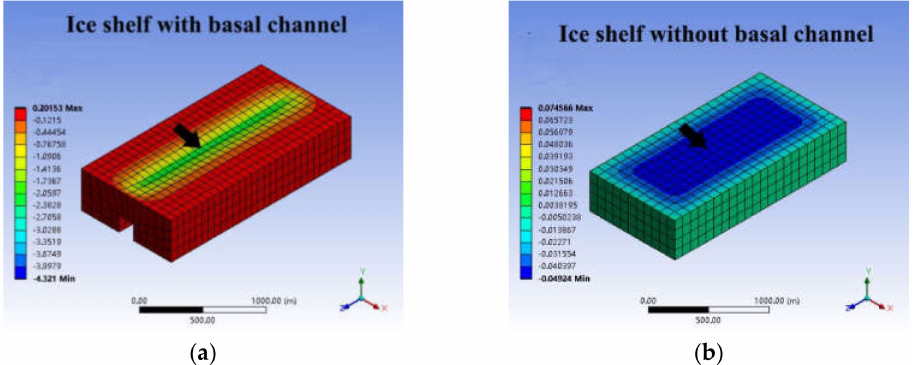
Figure 3. The annual deformation of the ice shelf under the action of its own gravity and buoyancy e ff ect of seawater. ( a ) The ice shelf with a basal channel, the corresponding position of surface appears obvious depression. ( b ) The ice shelf with no basal channel, there is no obvious depression on the ice shelf surface (1 year = 3.139 × 10 7 seconds). The model of the ice shelf is 2000 × 1000 × 400 m, and the basal channel is 2000 × 160 × 160 m. (Length × Width × Height). The model resolution is 100 m.